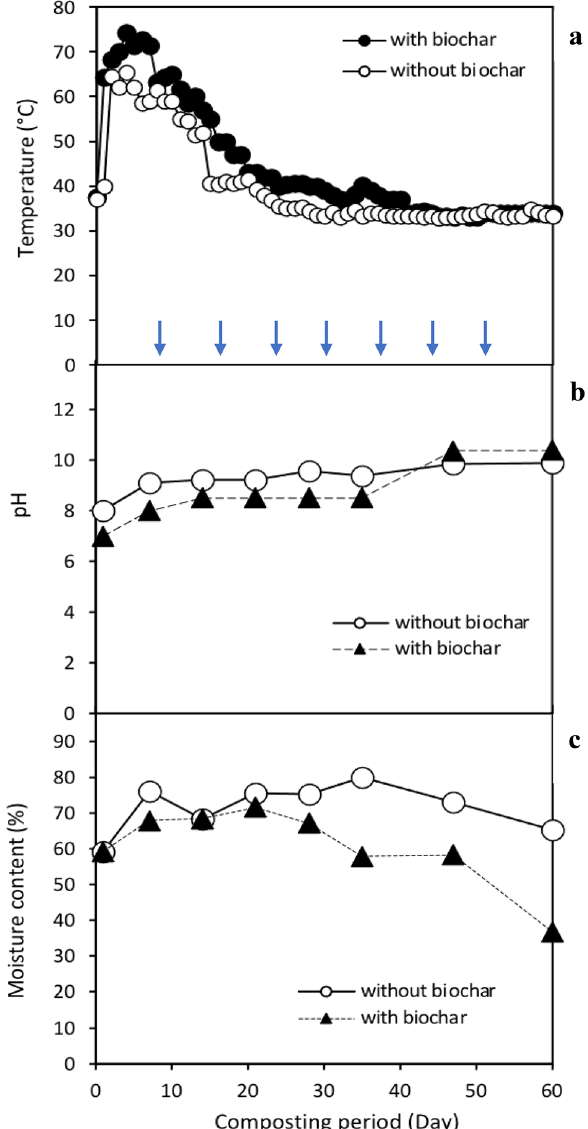
average of replicated samples. The temperature was recorded by inserting the probe horizontally into the core of the compost pile (90 cm) at 3 different positions (upper, middle and lower). The pH was recorded from the combined sample taken from different sampling points (middle and bottom part of compost